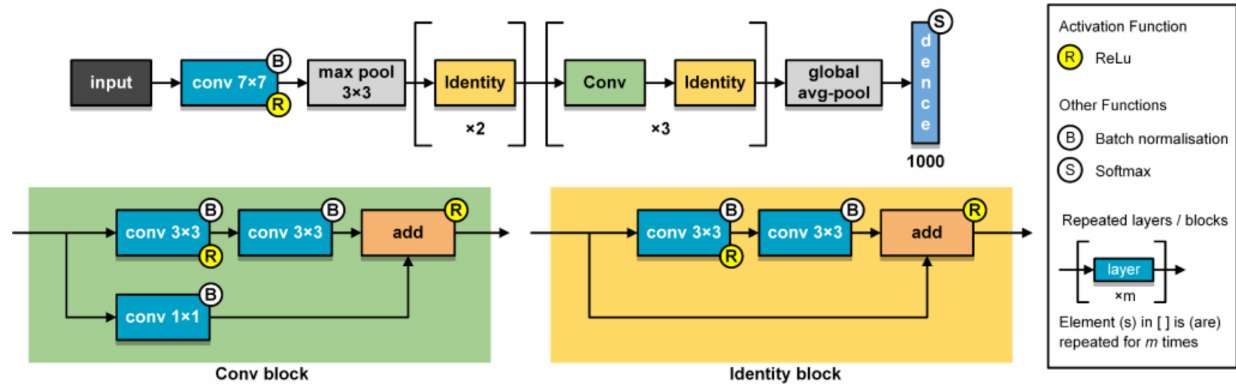
Figure 8. Detailed structure of the ResNet-18 feature extractor (adopted in Net-I, Net-II, and Net-III).